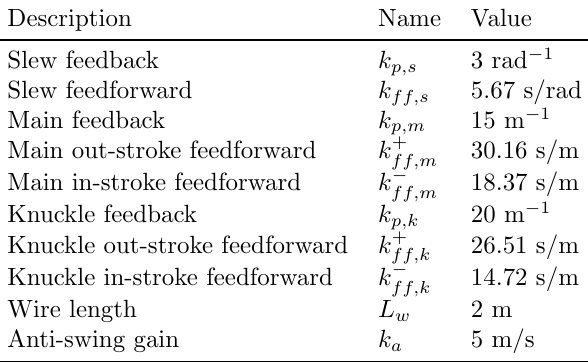
Table 7: Parameters used in